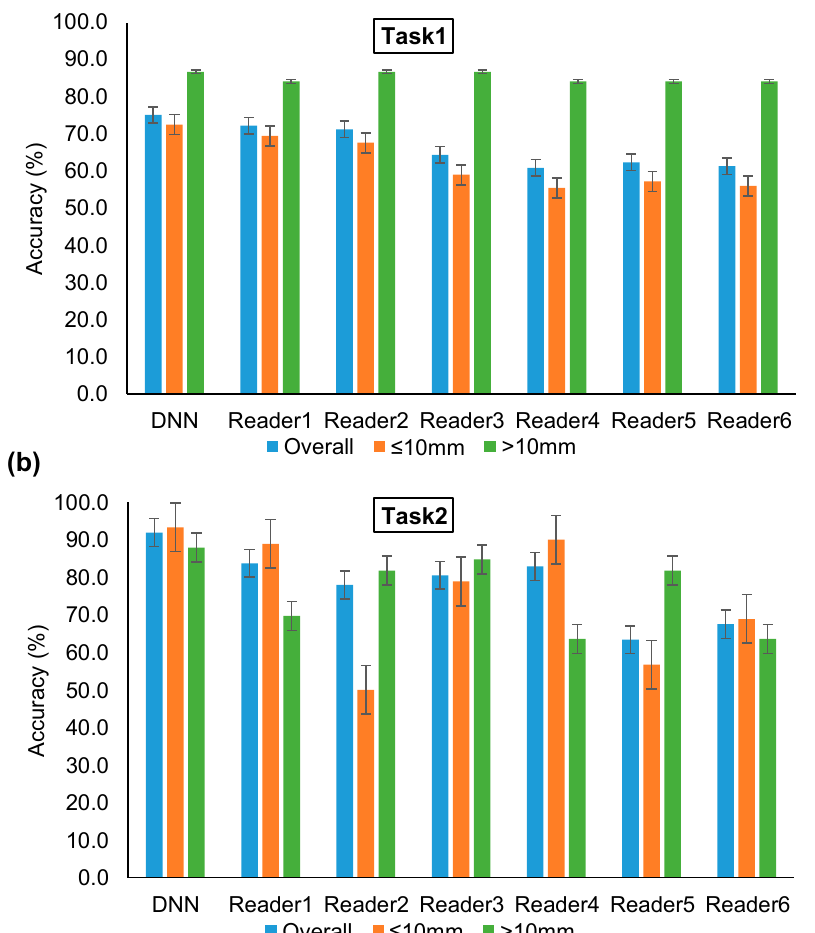
Figure 3. Comparisons of ROC curves and AUC values generated by DNN model and six readers (Table 2). ( a ) The Task1 ROC curves of DNN model and six readers. ( b ) The Task2 ROC curves of DNN model and six readers.